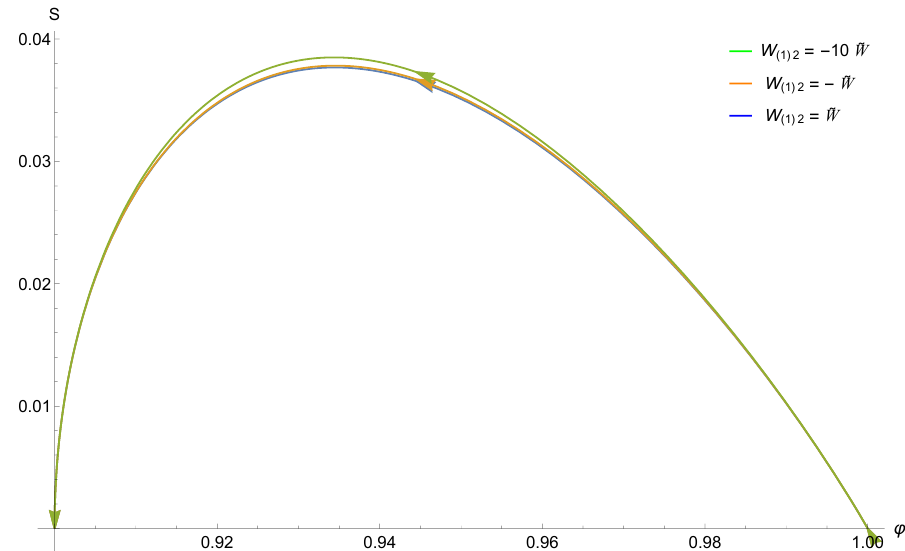
Figure 4 . Plot of the superpotential S as a function of ϕ for different choices of α , defined in (6.6), in the case of a Nut IR end-point. The IR endpoint for this plot has been chosen to be at ϕ The direction of the flow is indicated in the figure: it starts from the UV fixed point and ends in the IR. The different lines correspond to different choices of the integration constant W constant ˜ W is defined in (6.7). Note that the curves corresponding to W almost